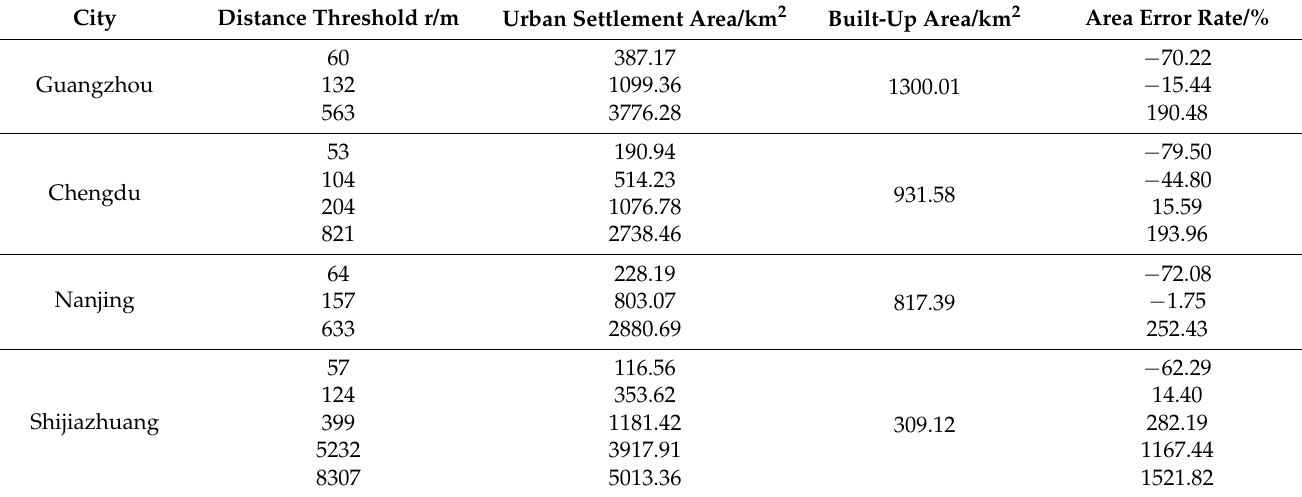
Table 4. Urban settlement